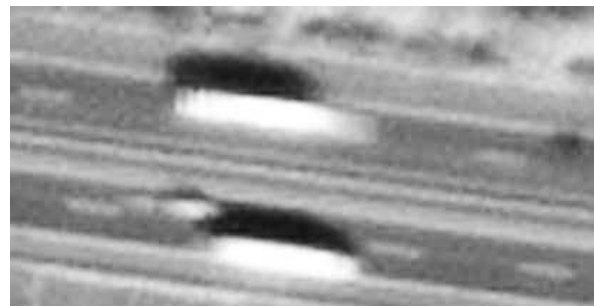
Figure 5: Moving car and trucks in SkySat Basic Panchromatic SkySat